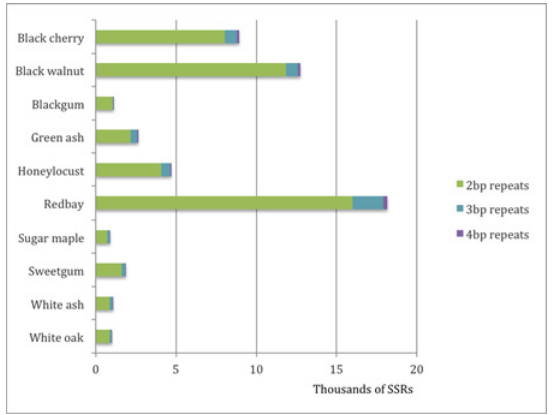
Fig 2. Number of PALs (potentially amplifiable loci) for each of ten hardwood tree species. Hundreds to thousands of PALs were identified for each species sequenced. For all species the most commonly identified repeat motif was 2 bases, followed by 3 base motifs. Reptitive motifs of 4 bases were found the least